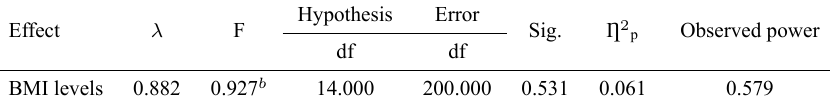
Table 2. The results of the Multivariate Tests a (MANOVA).